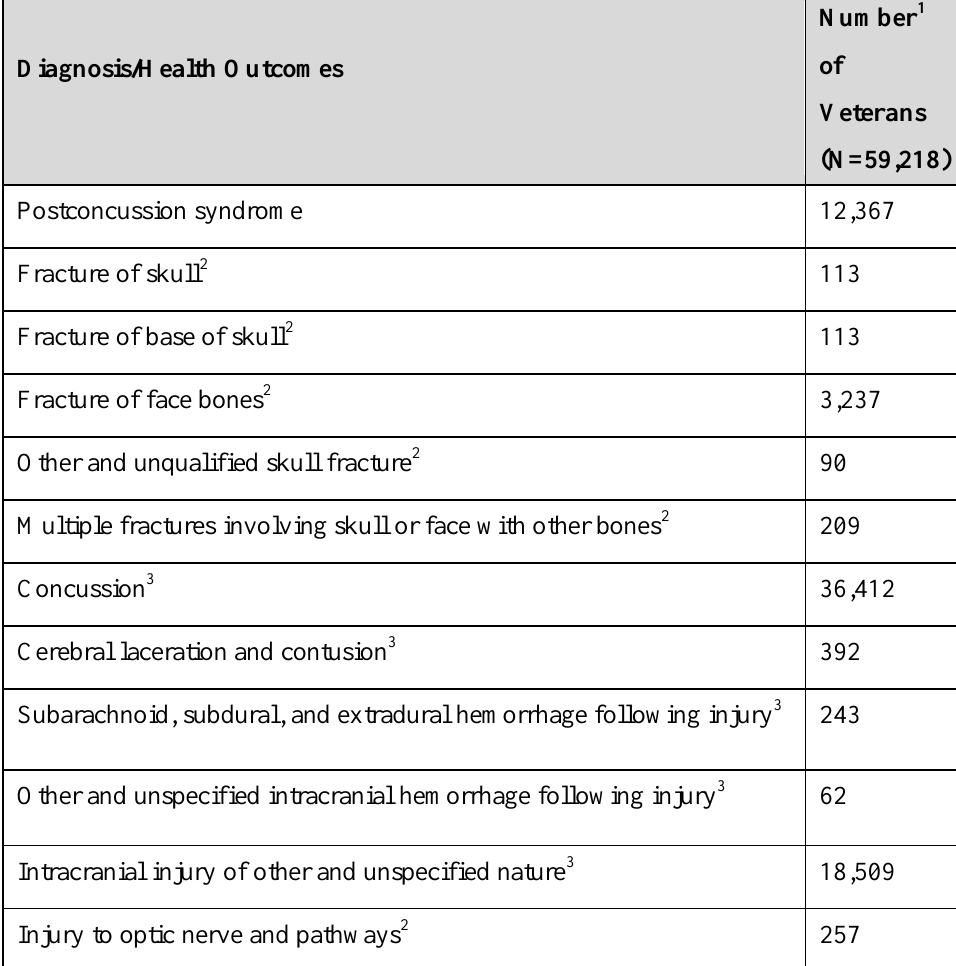
Table 7. Numbers of OEF/OIF Veterans Reported with ICD-9-CM Codes Indicative of TBI Diagnosis or a Selected TBI Outcome or Other Type of Head Injury Commonly Associated with TBI who were Evaluated or Treated in the VA Health-Care System